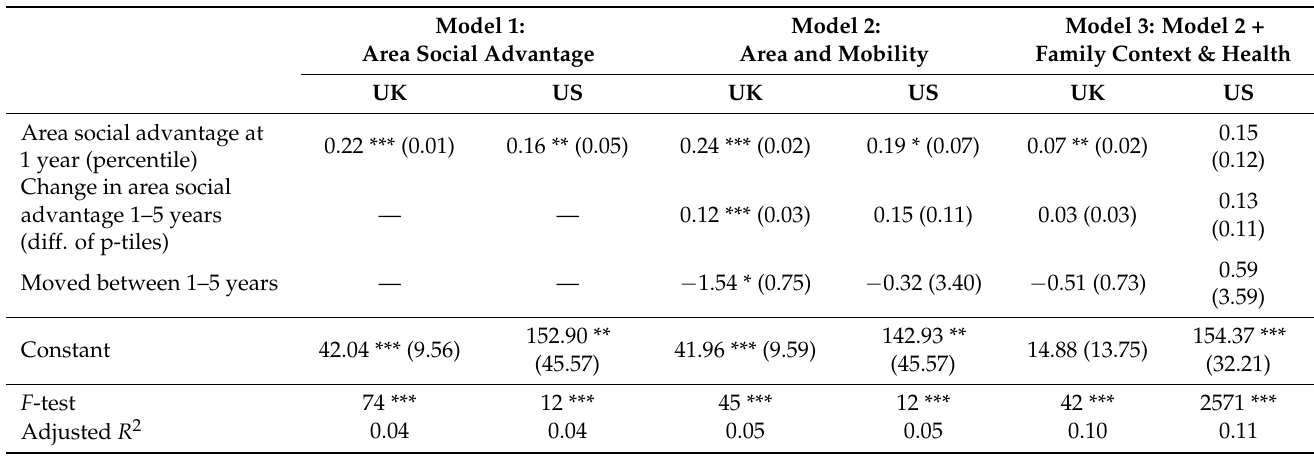
Table 4. Internalizing Behavior Adjustment at 5 years: Selected OLS Unstandardized Regressions Coefficients (Standard Error in parentheses) in UK (N = 7668) and US (N = 1820) a,b